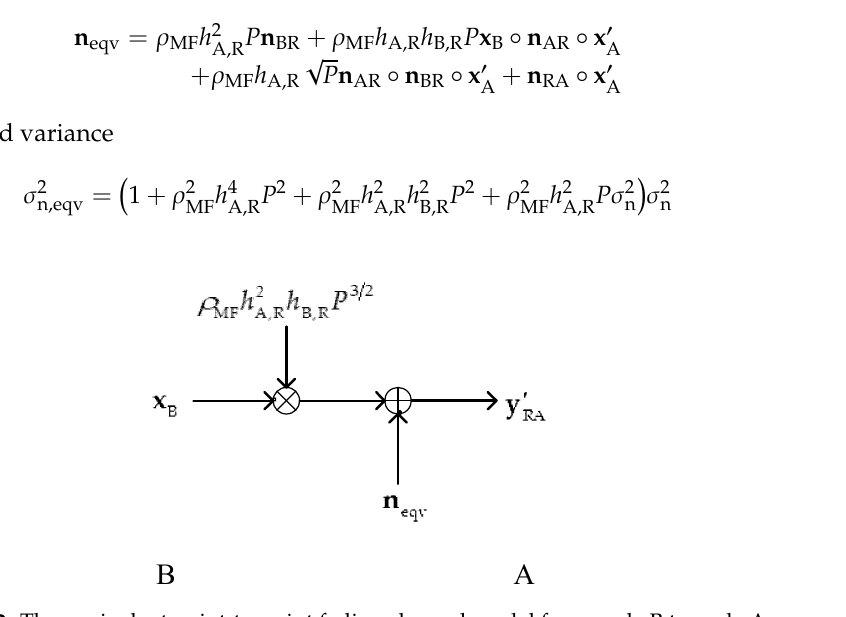
Figure 2. The equivalent point-to-point fading channel model from node B to node A.